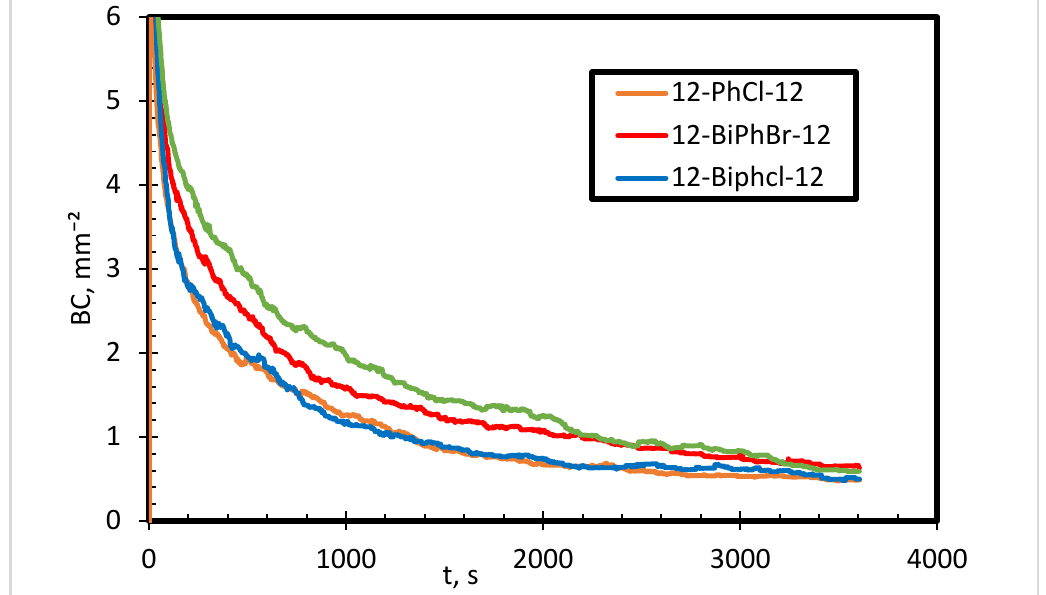
Figure 5. Bubble count of different surfactants in deionized water.